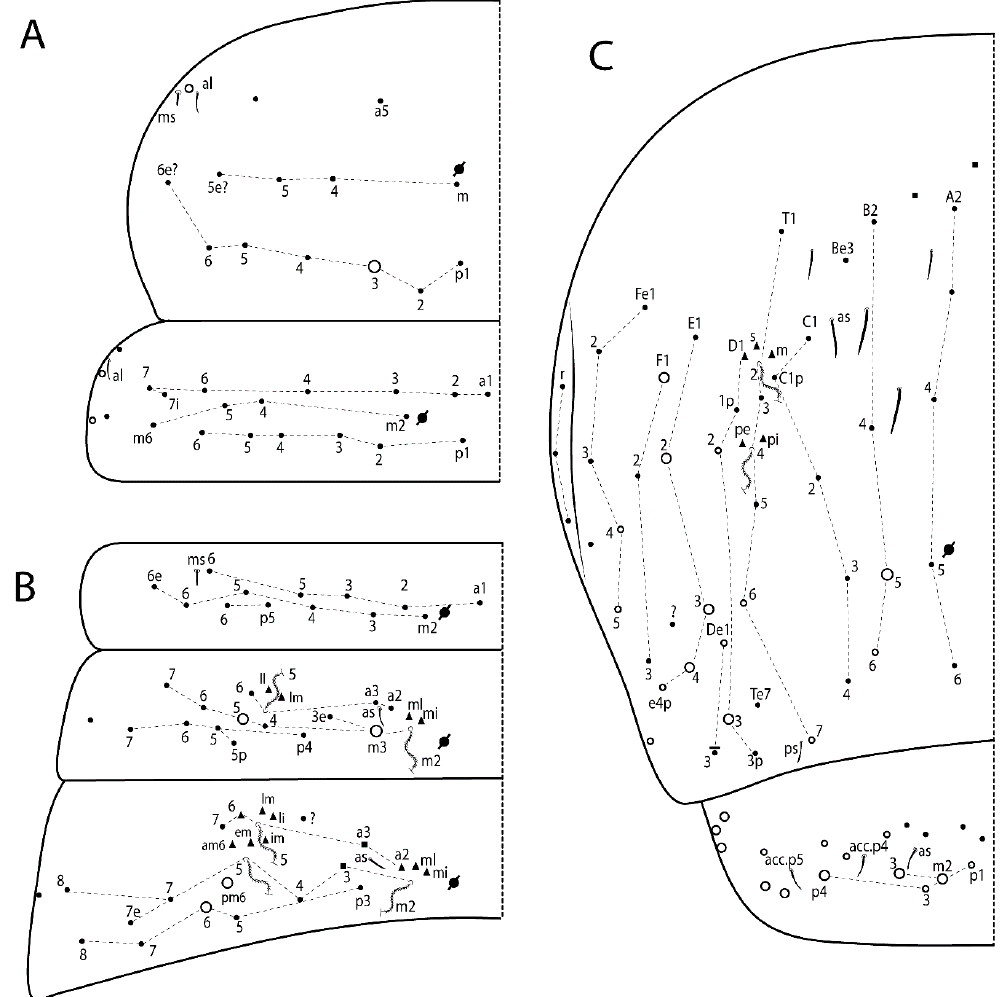
Figure 44. Pseudosinella cearensis sp. nov.: dorsal chaetotaxy. ( A ) Th II–III; ( B ) Abd I–III; ( C ) Abd IV– V.